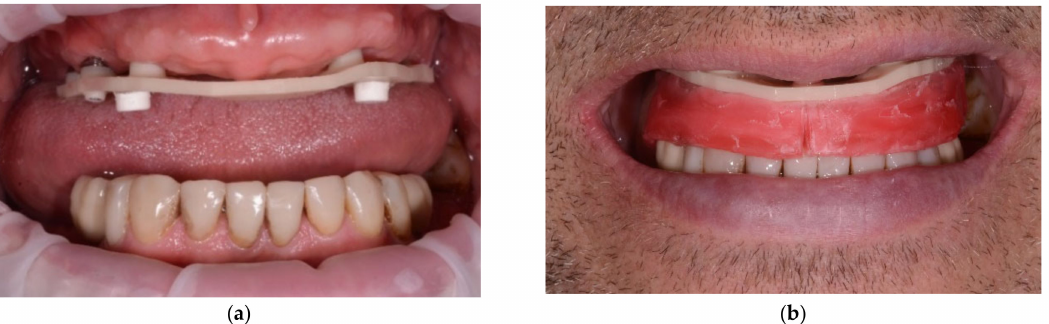
Figure 1. The analog bite registration was performed with use of a screw retained verification jig and a detachable wax rim: ( a ) screw retained PMMA (polymethyl methacrylate) verification jig on multi-unit abutment level with bilateral attachments (LEGO SYSTEM A/S, Billund, Denmark); ( b ) adjusted wax rim in CO position attached to the PMMA verification